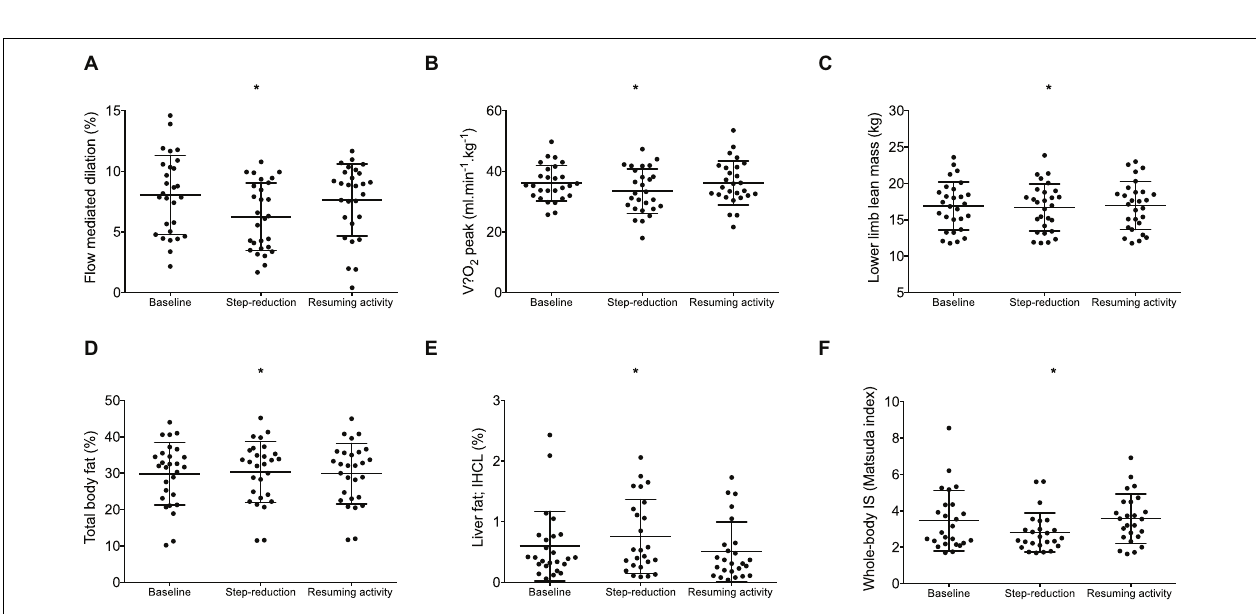
FIGURE 1 | Physical activity data for individuals at baseline, following step-reduction and resuming activity, including daily average step count (A) , TEE (B) , daily waking sedentary time ( < 1.5 METS) (C) , daily light activity (1.5–3 METS) (D) , daily moderate activity (3–6 METS) (E) , and daily vigorous activity ( > 6 METS) (F) . Data are presented as mean ± SD; * P < 0.05 main effect of time.